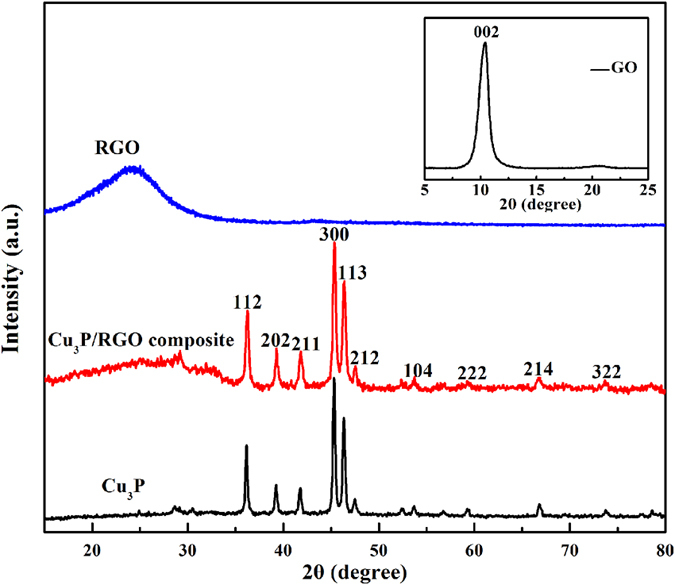
XRD patterns of GO (inset), RGO, Cu3P and Cu3P/RGO nanocomposite.